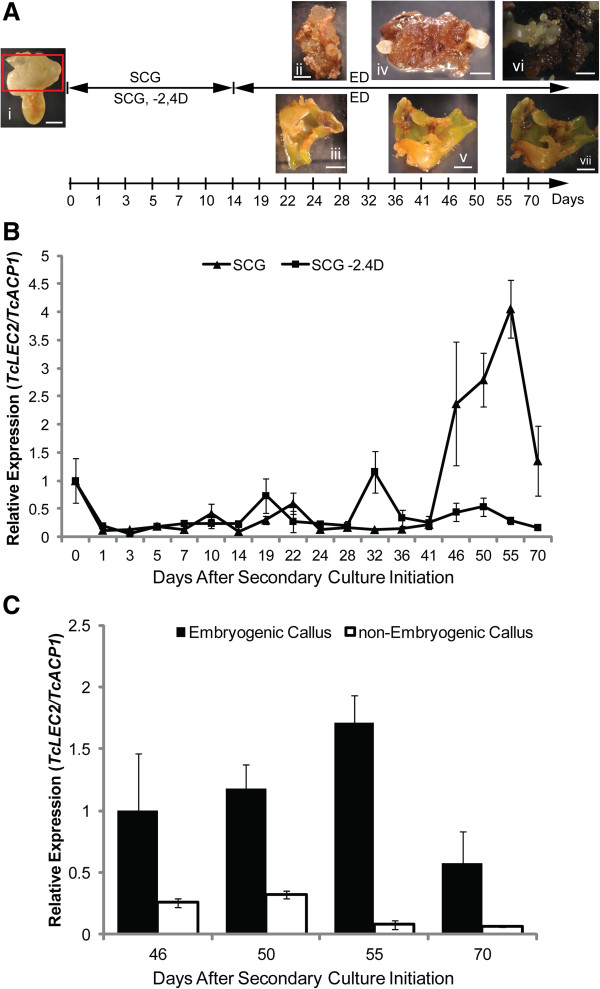
TcLEC2 expression correlates with embryogenic potential. A. Illustration of the cacao secondary somatic embryogenesis stages and time frame, indicating the points used for sample collections. Representative images of several key stages of embryo development: (i) cotyledon stage PSU-SCA6 embryo used as explants to initiate secondary somatic embryogenesis cultures; (i) & (iii) cotyledon explants on hormone-free medium at 28 days ACI, from cultures initiated on SCG medium containing 2, 4D and modified SCG without 2, 4D, respectively; (iv) & (v) cotyledon explants on ED at 46 days ACI (same treatments as above); (vi) & (vii) cotyledon explants on ED at 70 days ACI (same treatments as above); (Bars = 2 mm). B. Time course expression pattern of TcLEC2 during cacao secondary somatic embryogenesis from cultures initiated on SCG medium containing 2,4D and modified SCG without 2, 4D. Expression of TcLEC2 was normalized relative to that of TcACP1 (n = 3 or 4, mean ± SE). C. Expression levels of TcLEC2 at different time points in embryogenic and non-embryogenic calli. Expression of TcLEC2 was normalized relative to that of TcACP1. Bars represent mean ± SE (n = 3 or 4). Significance was established by t-test (*represents for p-value < 0.05).